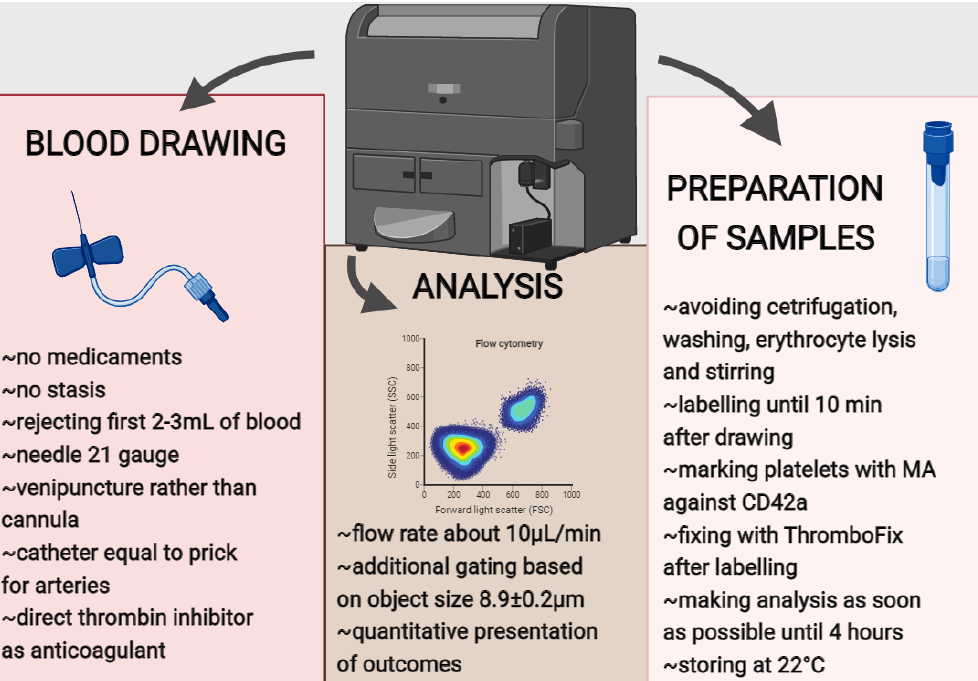
Figure 3. Recommendations regarding blood withdrawal, sample handling and platelet – leucocyte aggregates for measurement with conventional flow cytometry. Abbreviations: CD — cluster of dif- ferentiation; MA — monoclonal antibodies; min — minute; mL — millilitre; µm — micrometre; µL/min — microlitre per minute; °C — degrees Celsius.